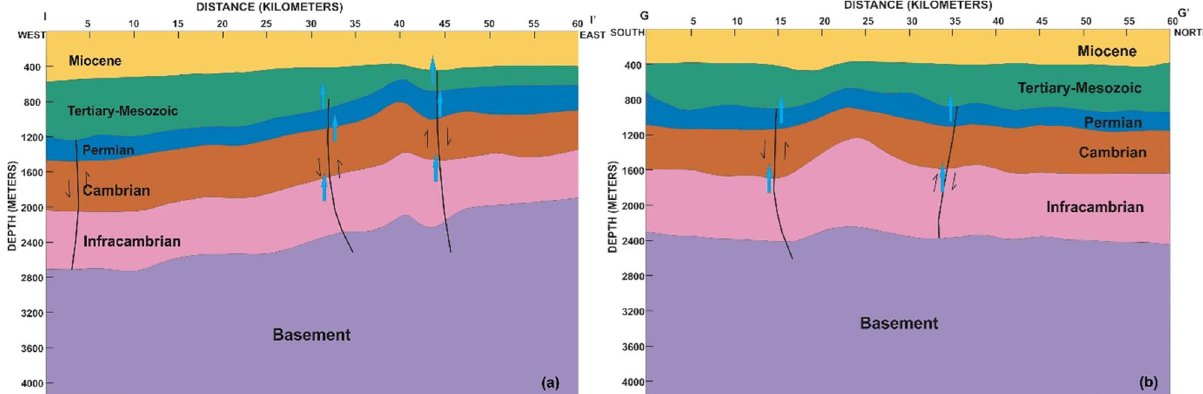
Figure 15. Seismic converted depth section indicating seepage through the main faults (shown with blue arrow): ( a ) along cross-section II ′ , and ( b ) along cross-section GG ′